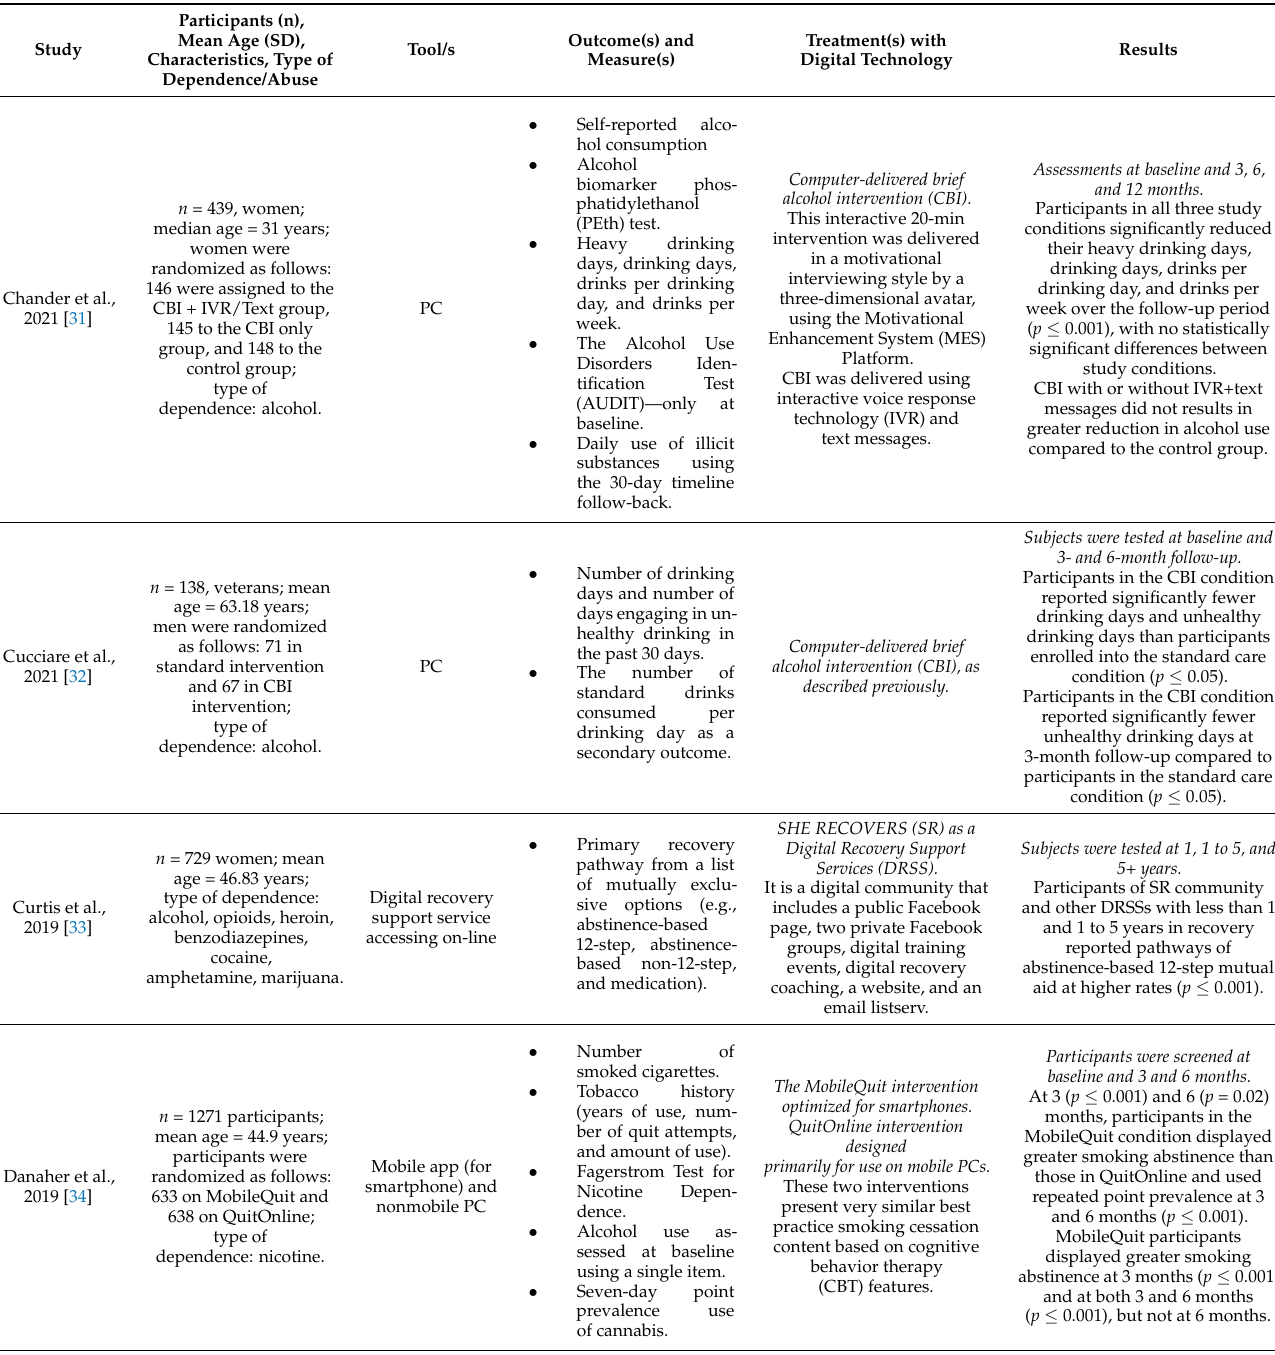
Table 1. Characteristics of publications of treatment(s) with digital technology included in review (N =